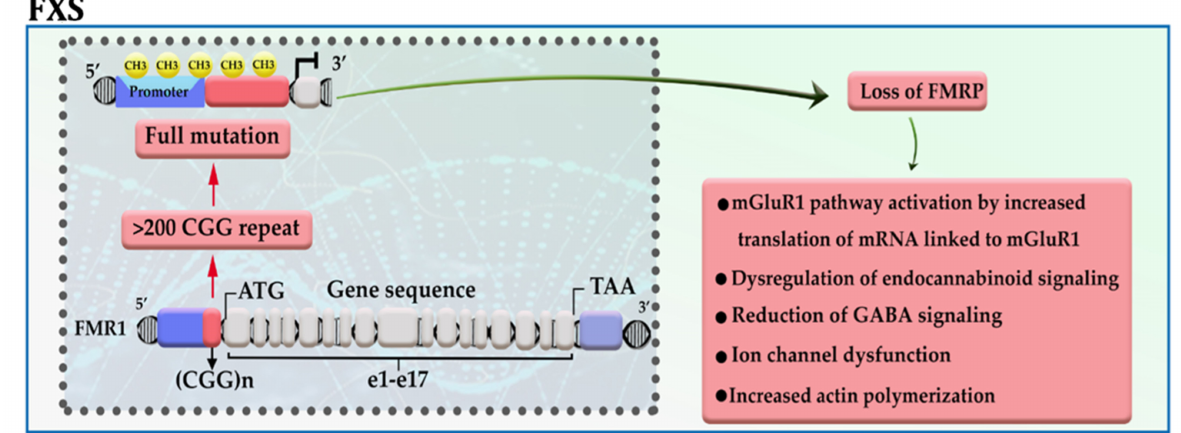
Figure 1. A schematic representation of the selected mechanisms in the pathogenesis of FXS. The presence of more than 200 copies of CGG repeat in the 5 (cid:48) UTR region of the FMR1 gene leads to promoter hypermethylation, transcriptional silencing, and loss of FMR protein. mGluRI: group 1 metabotropic glutamate receptors; GABA: gamma-aminobutyric